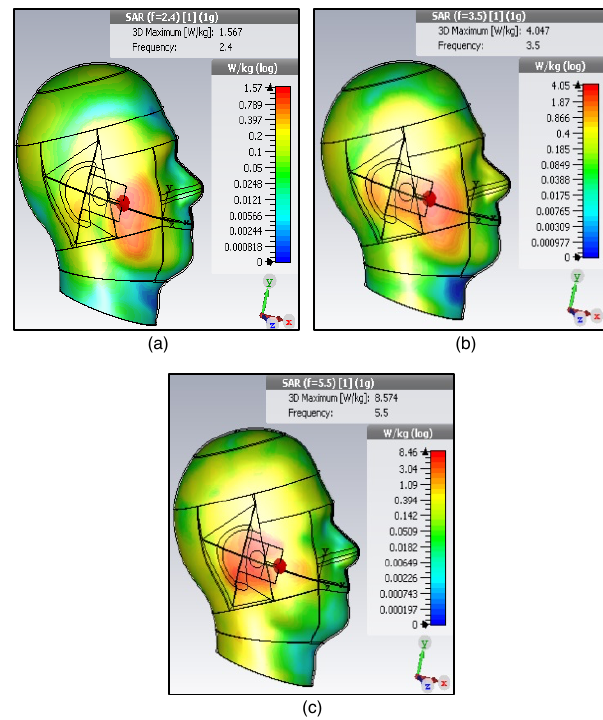
Figure 8. Radiation pattern of UWB-CMSA (a) XZ plane (b) YZ plane.